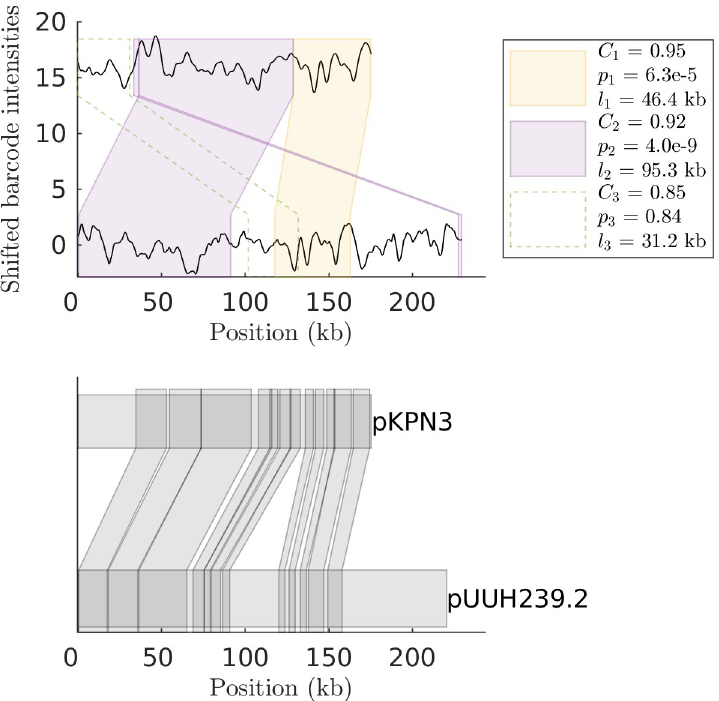
Fig 6. HMM output for plasmid experiment against an ancestor plasmid DNA sequence of the bacterial resistance plasmid. (Top) HMM output of an experimental consensus barcode for the pUUH239.2 plasmid compared to the theoretical DNA barcode for the ancestor (the pKPN3 plasmid). Note that we successfully identified the matching barcode-pair regions predicted by the BLAST alignment. (Bottom) BLAST output of 12 longest sub-sequence pairs with matching similarity of at least